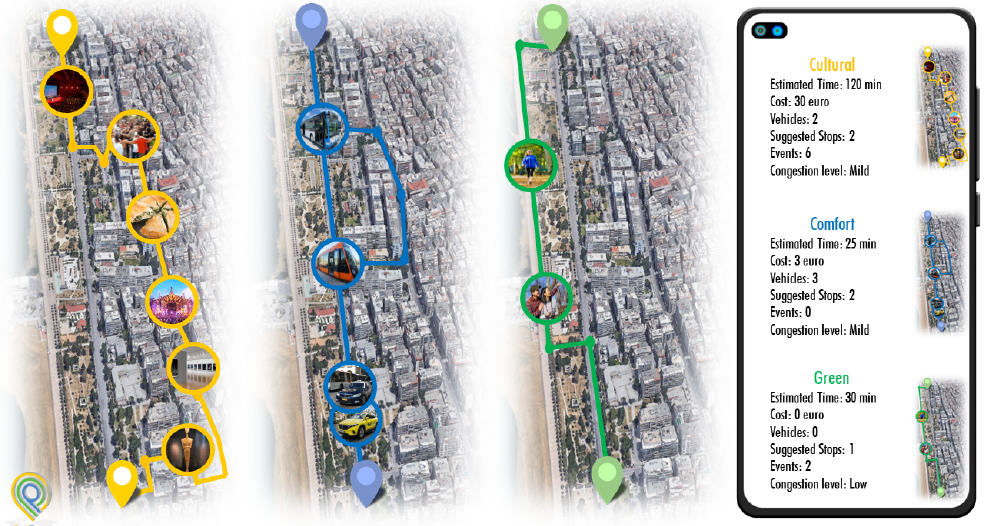
Figure 2. OptiTours proposed